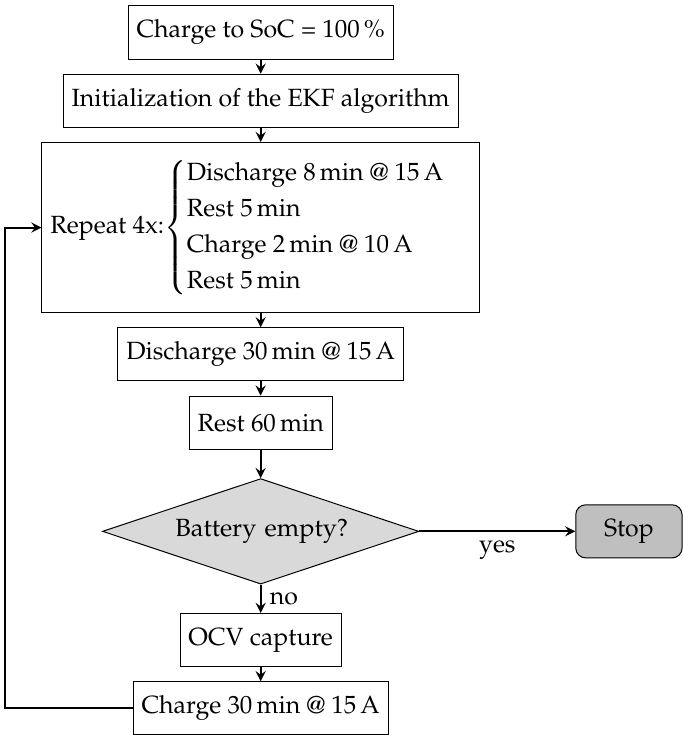
Figure 7. Procedure of the